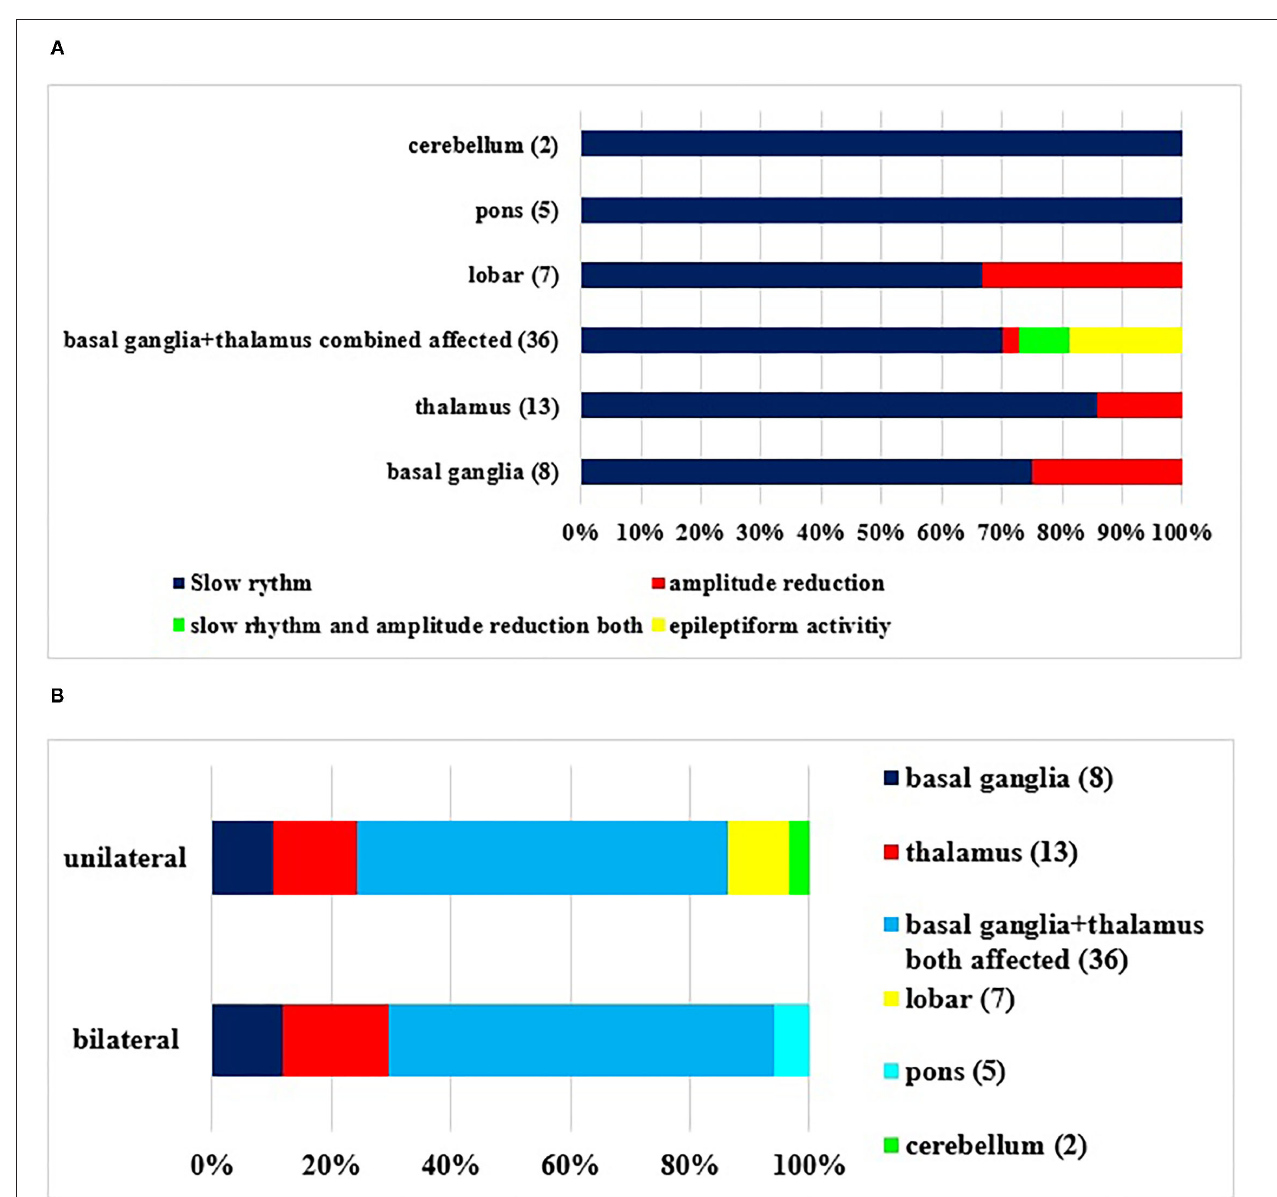
FIGURE 3 | (A,B) Abnormalities in EEG during the examined period in accordance with the localization of primary source of the bleeding. The definitions of EEG alterations are given in detail in Methods . (Number of patients). There was a significant correlation between the type of EEG abnormality and localization ( p <